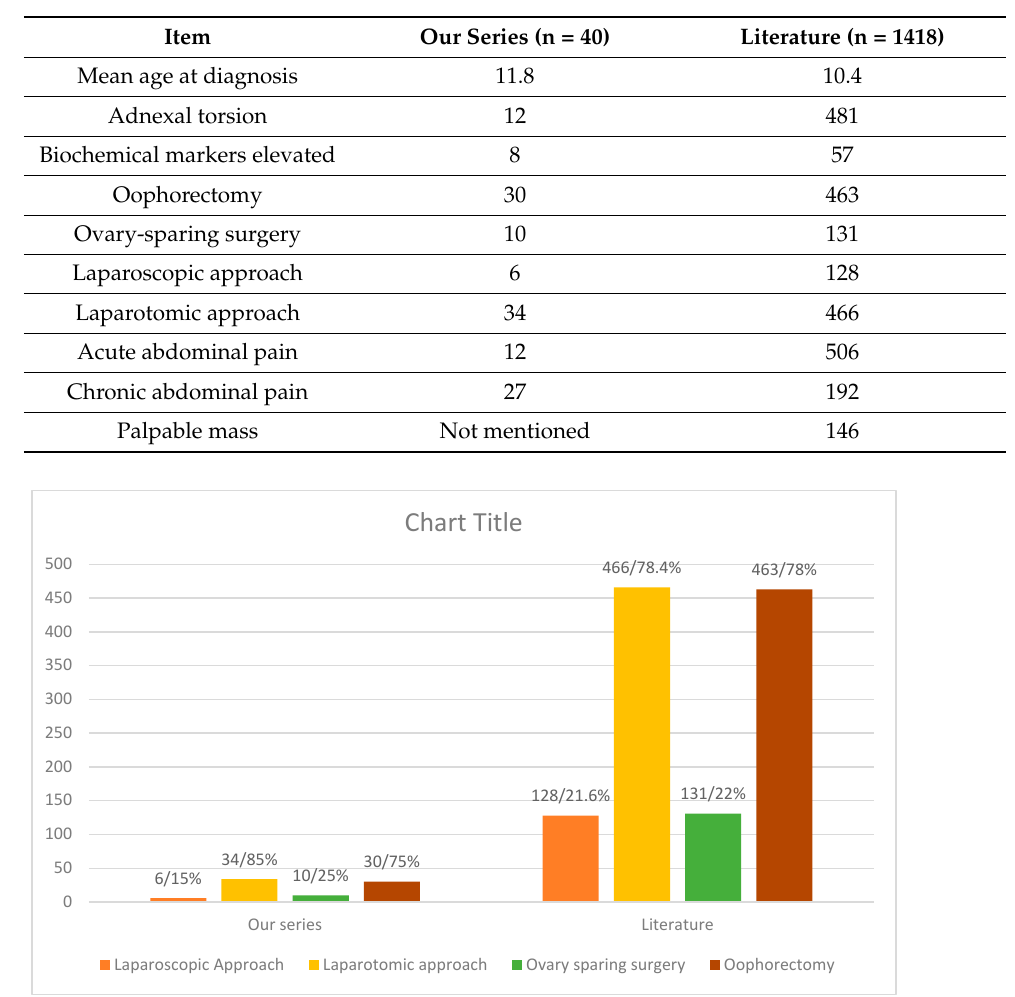
Table 1. Data from our series and from literature review.